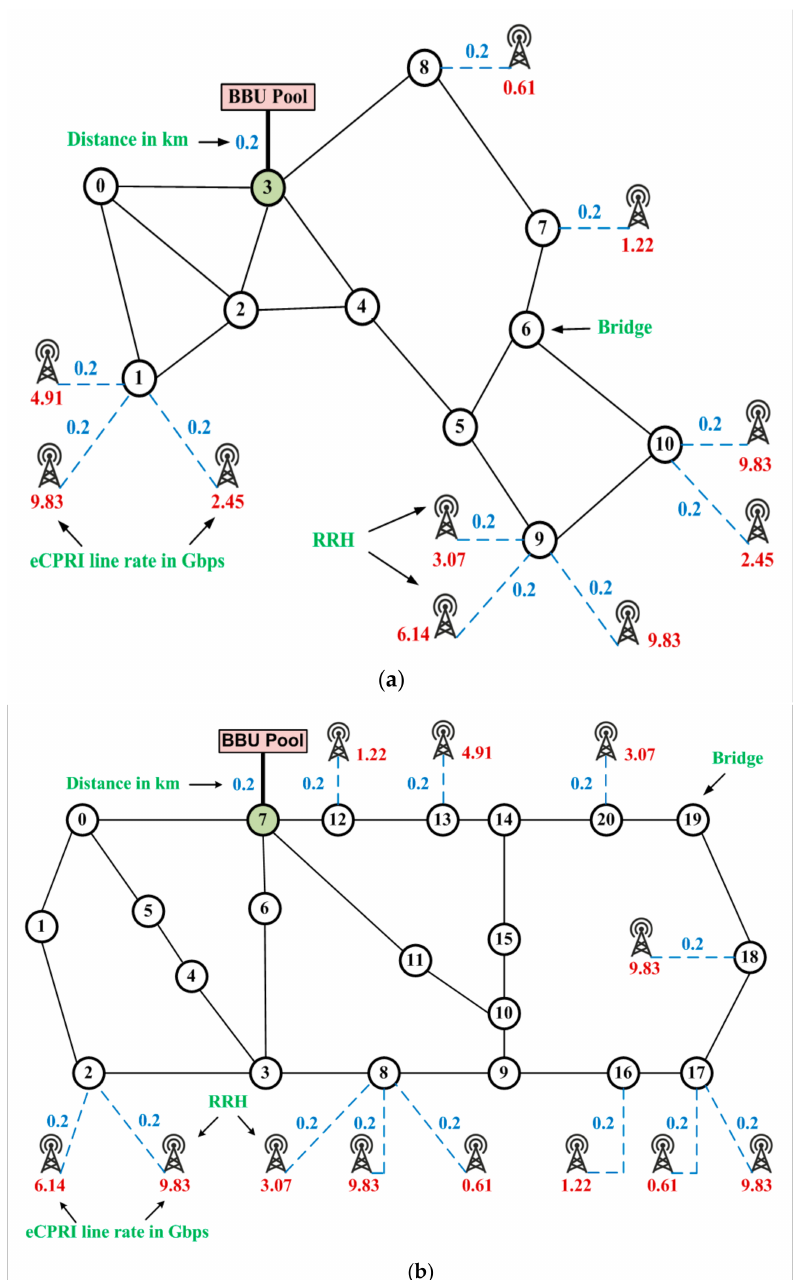
Figure 4. Considered network topologies for the evaluation of the proposed and existing schemes. ( a ) COST239; ( b )